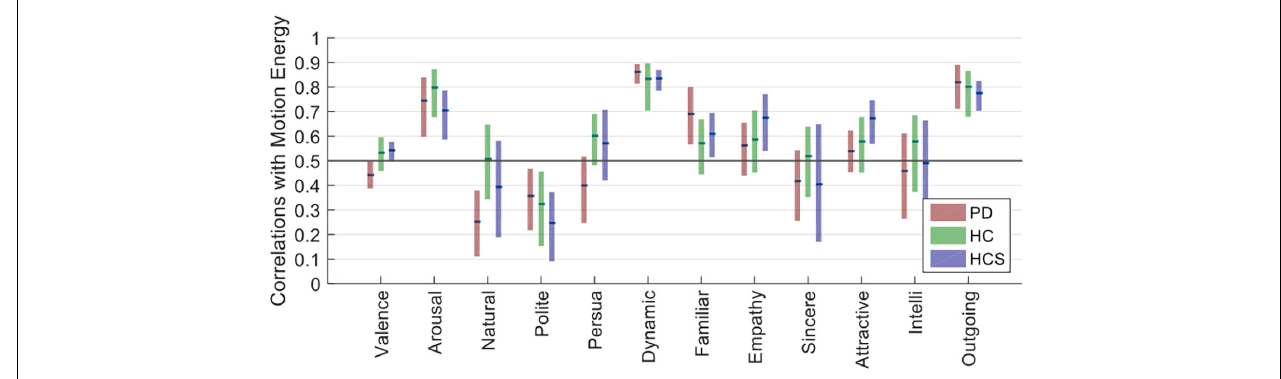
FIGURE 6 | Optical flow estimate correlations with 12 dimensions for PD, HC, and